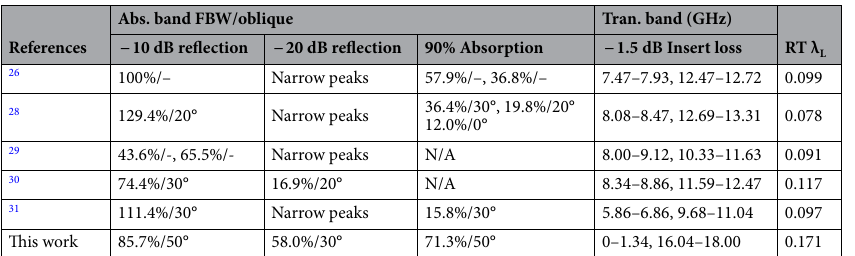
Table 1. Performance comparison of TAT rasorbers, relative thickness (RT), which corresponds to the starting frequency of − 10 dB reflection (λ L